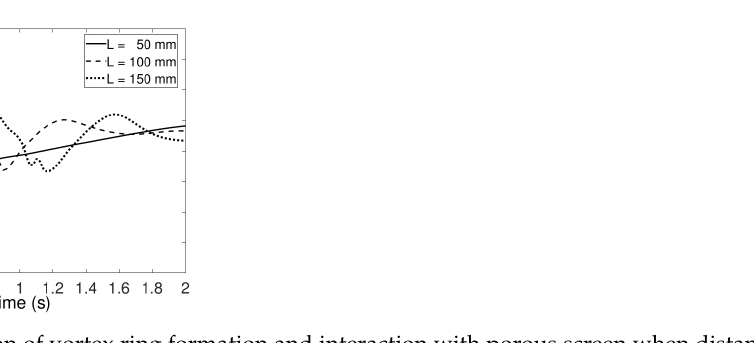
Figure 17. Evaluation of vortex ring formation and interaction with porous screen when distance between air outlet and porous screen is